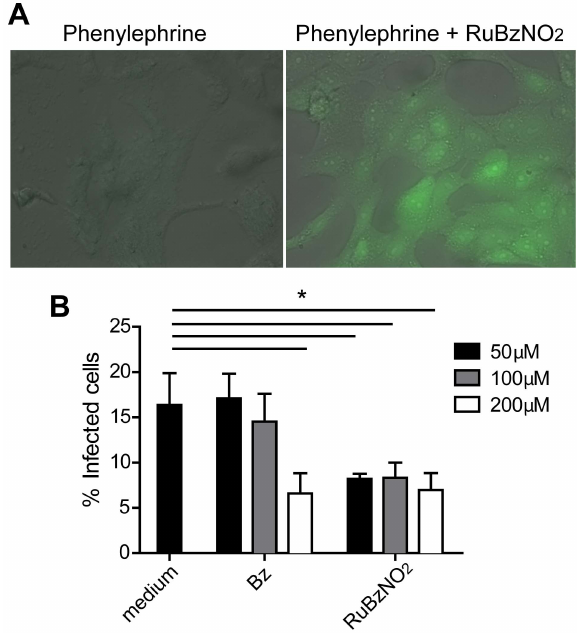
Figure 3. RuBzNO 2 is able to release NO inside the cell and kills the amastigotes. A. Vero cells were incubated with DAF-2 DA and the reducing agent phenylephrine in the presence or absence of RuBzNO 2 . The formation of the fluorescent compound (DAF-2T), which occurs in the presence of NO in the cytoplasm, was assessed by fluorescence microscopy. B. Cells were incubated with trypomastigote forms of T. cruzi for 24 h at 37 u C. The remaining parasites were washed from the culture, and the cells were incubated at 37 u C for an additional 24 h. Cells were stained with Giemsa dye, and the percentage of infected cells was determined by optical microscopy. The bars indicate means + SEM of triplicates and are representative of two independent experiments. * represents p ,